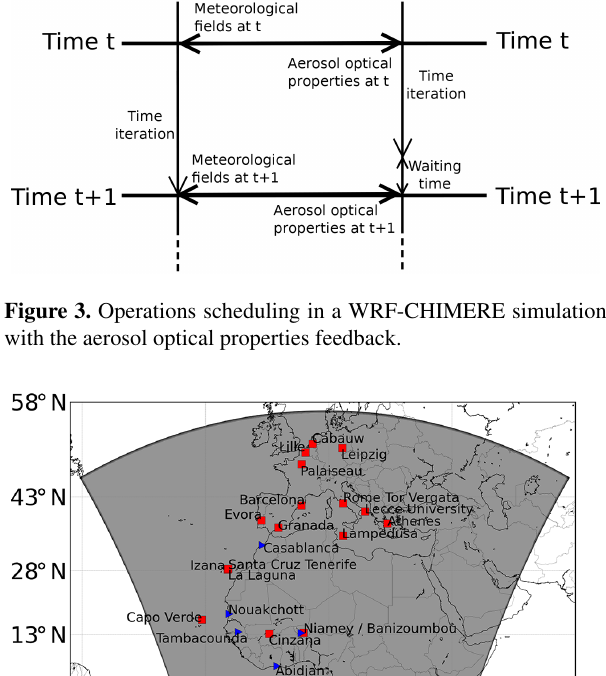
Figure 4. Simulated domain used in Sects. 4 and 5. AERONET stations are depicted with red squares and temperature atmospheric sounding stations with blue